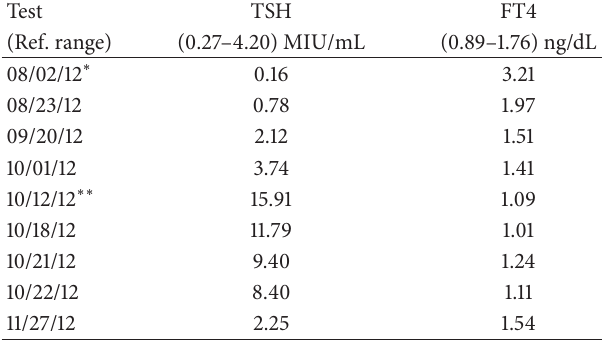
Table 1: Serial thyroid function tests after oral and IV